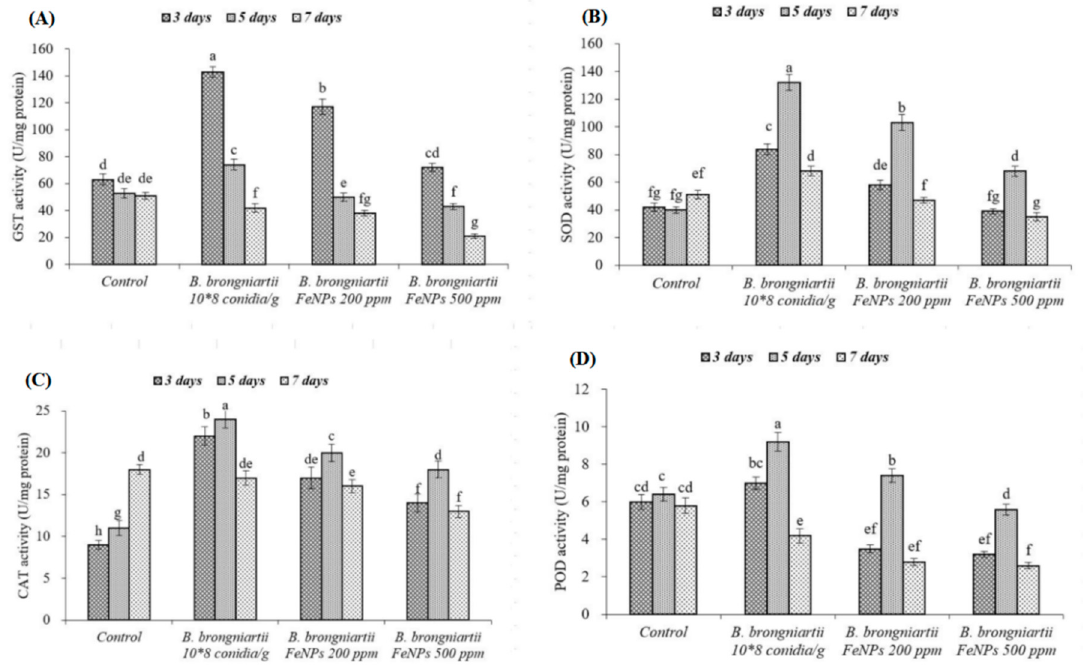
Figure 7. Detoxifying enzyme produced by 2nd instar Spodoptera litura larvae in response to different treatments of Beauveria brongniartii Fe 0 NPs, B. brongniartii and control after 3, 5, and 7 days of treatment. ( A ): glutathione-S-transferase (GST); ( B ) superoxide dismutase (SOD); ( C ) catalase (CAT); and ( D ) peroxidase (POD). Error bars indicate standard error of means. Different letters above columns indicate significant differences between means at a 5% level of significance.